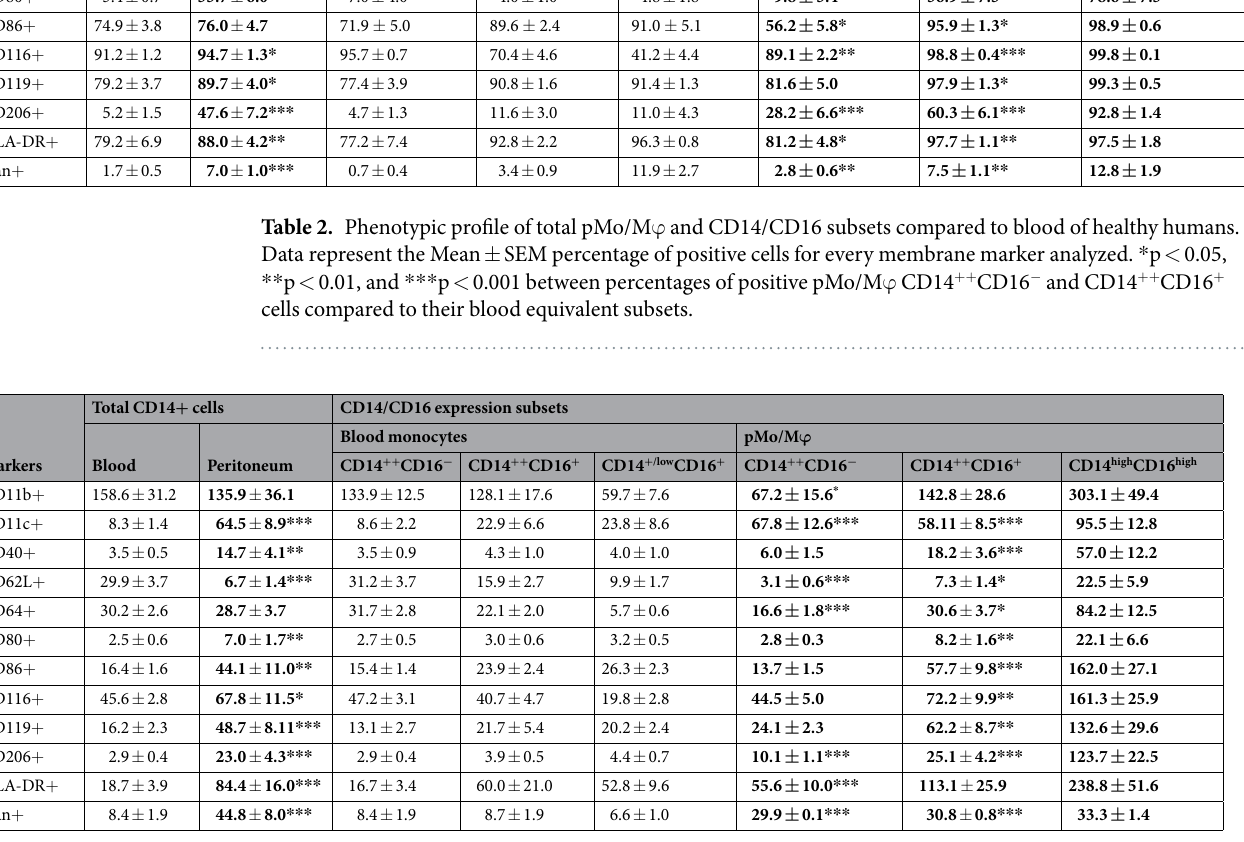
Expression of GATA6 in human peritoneal macrophages. Trying to discriminate between mature res- ident peritoneal macrophages and newly migrated blood monocytes, we analyzed the intracellular expression of transcription factor GATA6, which has been described as a central regulator of the murine peritoneal macrophage phenotype. The results showed that while GATA6 was absent in peripheral blood monocytes (Fig. 3a,b), the per- centage of GATA6 + cells in the peritoneal cavity was rather high (80.1 ± 11.4%) (Fig. 3c). Next, we analyzed the percentages of GATA6 + cells within each CD14/CD16 peritoneal subset. As displayed in Fig. 3d, the results did not show significant differences in the ratio of positive cells among the three peritoneal subpopulations; although there was a trend toward a higher number of GATA6 + cells within the more complex CD14 high CD16 high subpop- ulation (86.1 ± 8.6%), followed by the intermediate subset (83.3 ± 10.0%), and the classic-like CD14 ++ CD16 − subpopulation (79.2 ± 12.1%). Representative FACS histograms and quantitative analysis of GATA6 MFI within each pMo/pM ϕ subpopulation are displayed in Fig. 3d. Similarly to the percentages of GATA6 positive cells, the intensity level of cell expression within each peritoneal subset was directly related to the cell complexity, and therefore to the expression of CD14 and CD16. The analysis of GATA6 intensity expression (MFI) related to the corresponding MFI of CD14 and CD16 showed a clear correlation (R 2 = 0.9957 and R 2 = 0.9992, respectively) (Fig. 3e). Thus, taking into account the results reported from the mouse model, these data reveal that, in spite of their phenotypic differences, the majority of resident pMo/M ϕ in homeostasis highly express the transcription factor GATA6. The mature and more active cells would mostly correspond to the complex CD14 high CD16 high and,